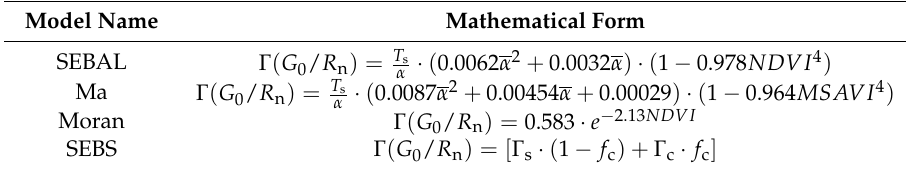
Table 3. Common remote sensing-based models for estimating Γ ( G 0 / R n